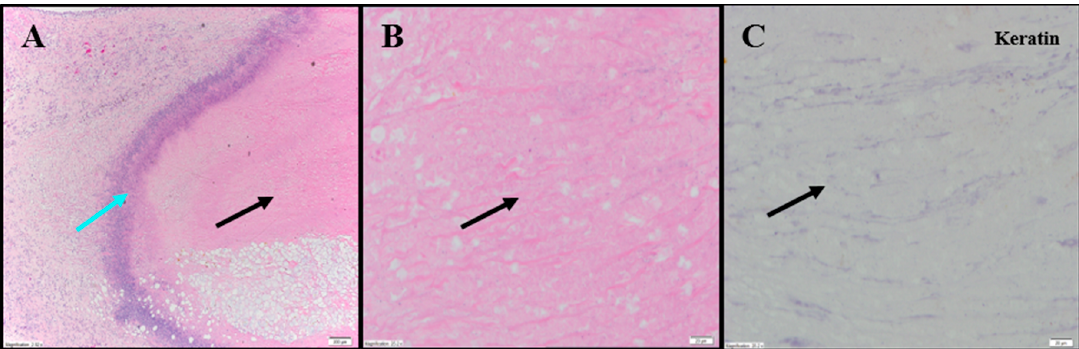
Figure 6. Representative photomicrographs of renal tumors administered 3× IT NanoDoce ® . ( A ) Dense amorphous necrosis (black arrow) demarcated from surrounding fibrofatty tissue by a band of necrotic debris and admixed ICs (blue arrow) 4×. ( B ) Necrotic area from A : no viable nucleated TCs (black arrow) 40×. ( C ) Same as B: absence of residual carcinoma evidenced by lack of anti-AE1/AE3 staining (black arrow) 40×.